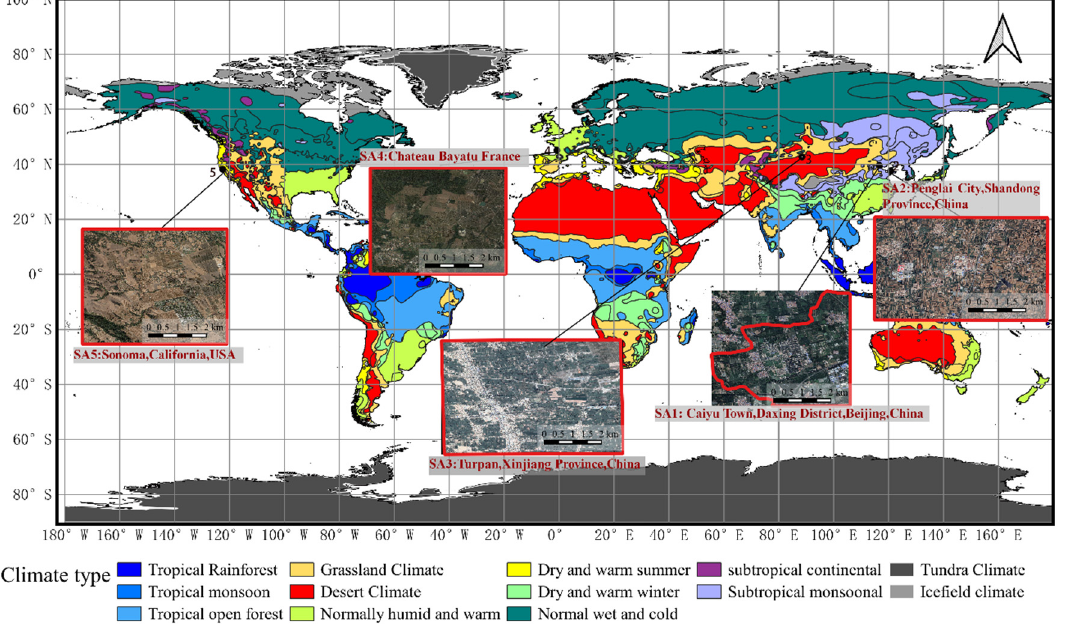
Figure 1. The five grape-growing regions, distributed in different climatic zones around the world, are SA1: Caiyu Town, Daxing District, Beijing, China; SA2: Penlai City, Shandong Province, China; SA3: Turpan, Xinjiang Province, China; SA4: Chateau Bayatu France; SA5: Sonoma, CA, USA.